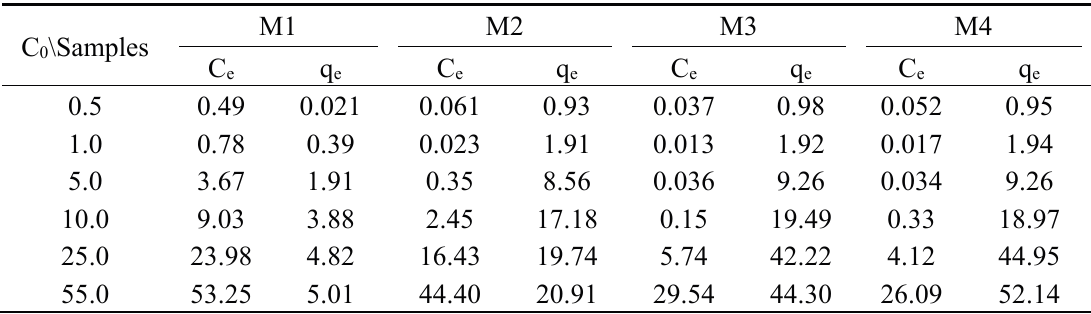
Table 1. Adsorption data of four adsorbents for phosphate removal in solution with different initial